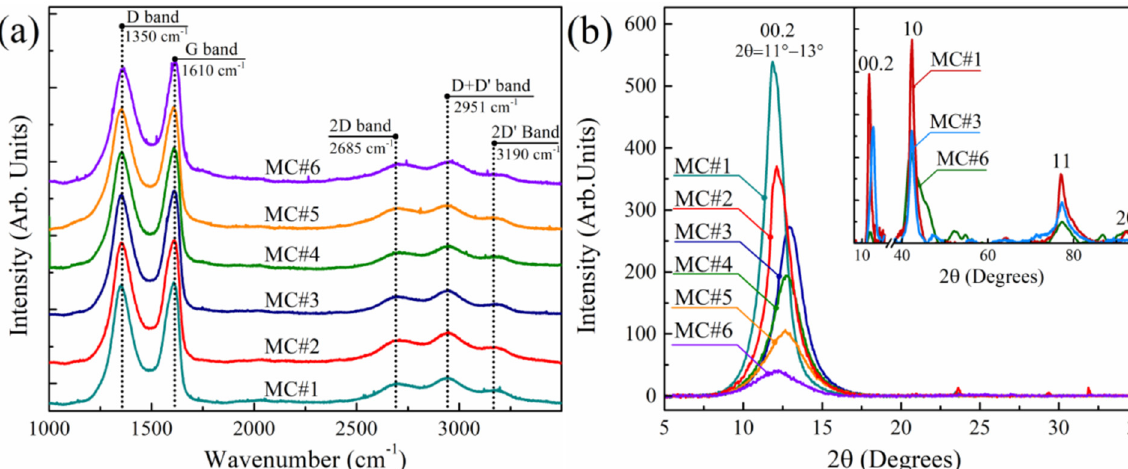
Figure 6. ( a ) Raman spectra of the MC#1–MC#6 samples. The spectra are vertically offset for clarity. ( b ) XRD powder patterns of the MC#1–MC#6 samples, measured within the range of 2 θ from 5° to 35° using the reflection geometry. Inset: XRD patterns of the MC#1, MC#3, and MC#6 samples measured using transmission geometry. The area of 2 θ = 18–35°, containing the signal from the needle used to fix the samples, is excluded. The relative intensities of the 00.2 maxima of MC#1, MC#3, and MC#6 in the XRD patterns measured using the reflection and transmission geometry are equal.